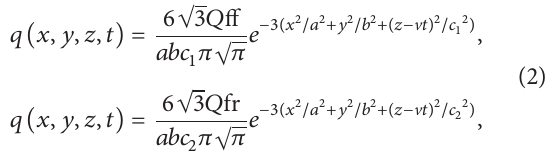
Figure 9: 3D finite element model of 75 mm wide welding seam.